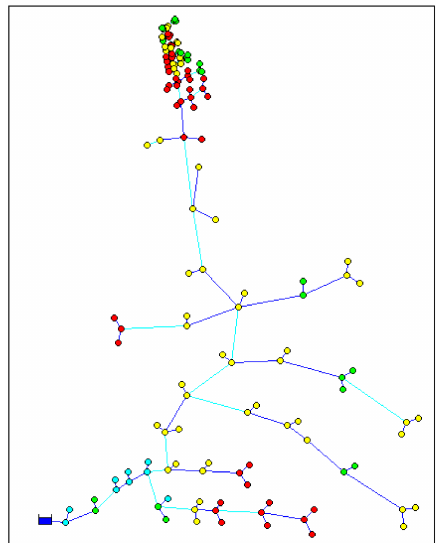
Figure 1. Tuncarta Irrigation